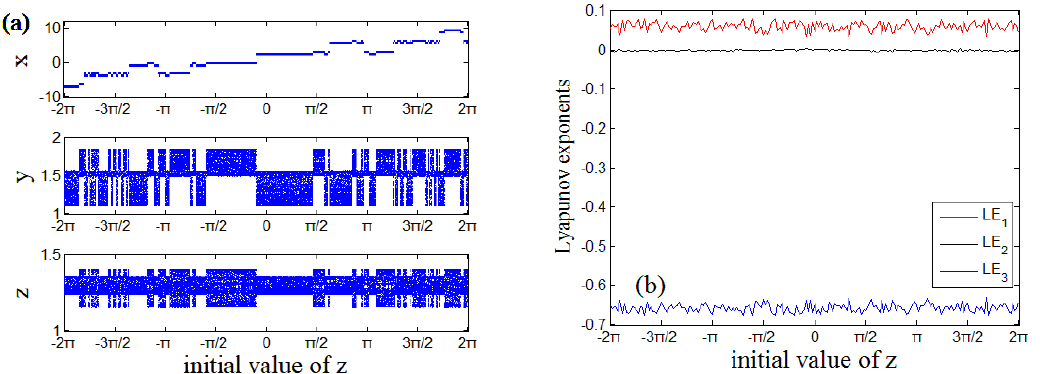
Figure 9. ( a ) Bifurcation diagram and ( b ) Lyapunov exponent spectra versus initial value z 0 , when a = 1.5, b = 0.6, c = 1.0, d = 2, x 0 = 0.1, y 0 = 0.01.